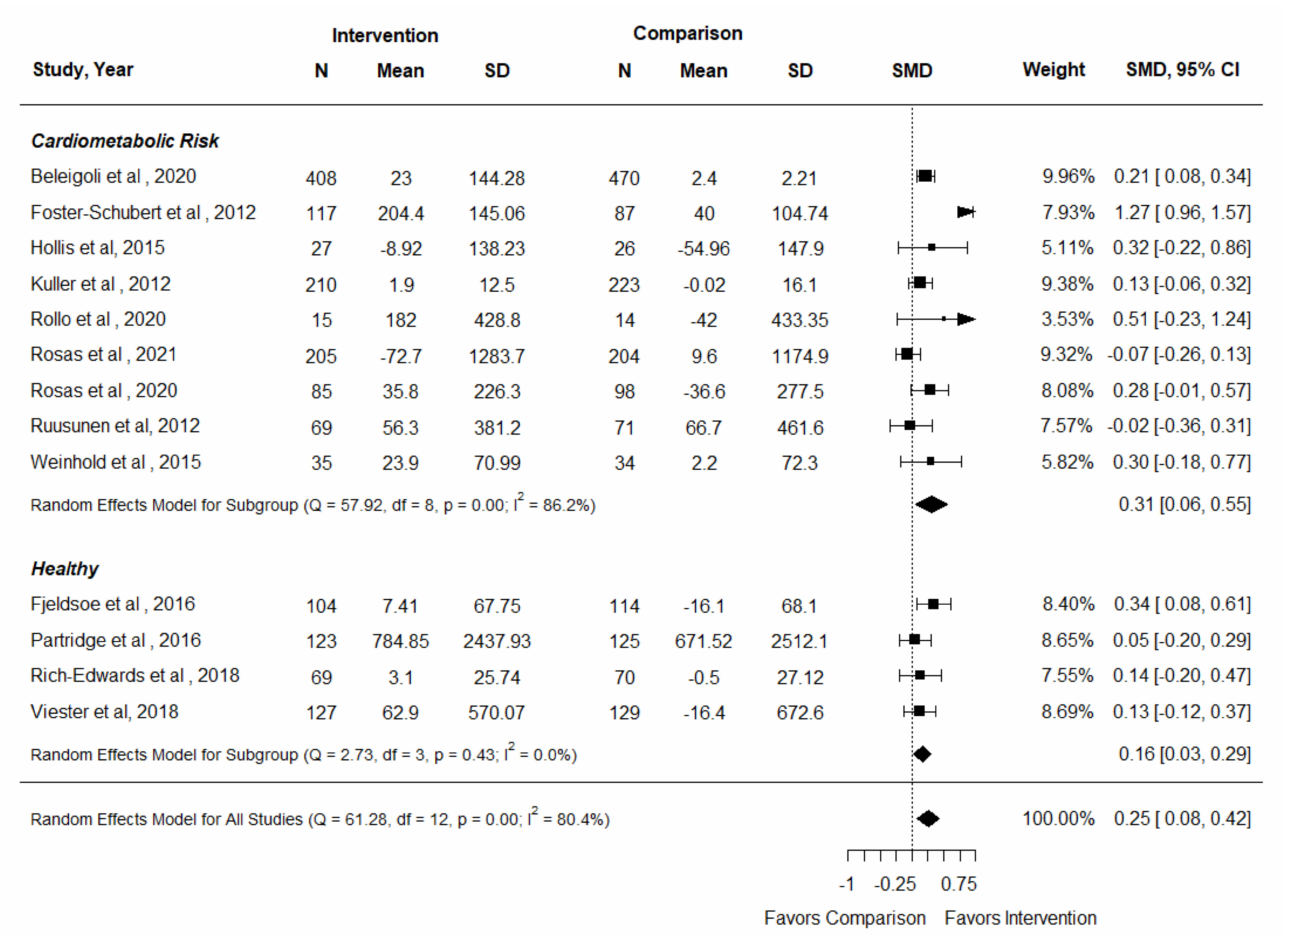
Figure 3. Forest plot for physical activity amount in the systematic review examining effect of nutrition and physical activity interventions provided by nutrition and exercise practitioners for the general population